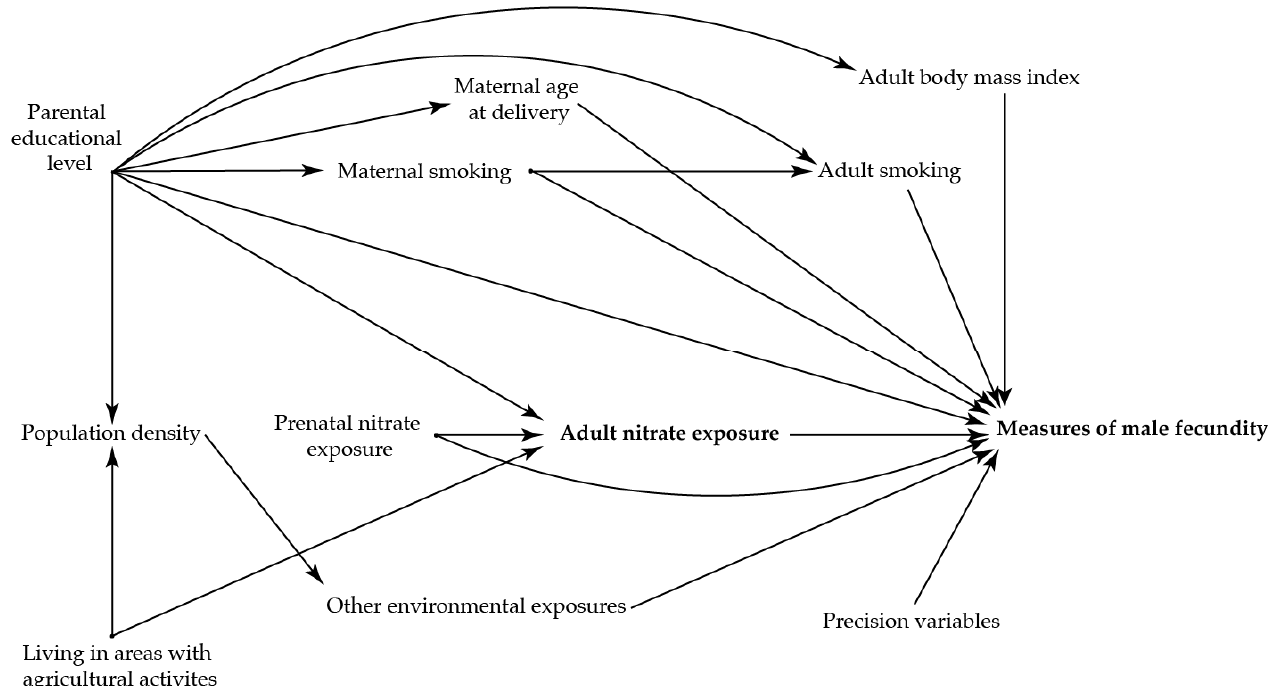
Figure 2. Directed acyclic graph illustrating the suggested associations between nitrate concentration in maternal drinking water and the reproductive health in the adult sons.